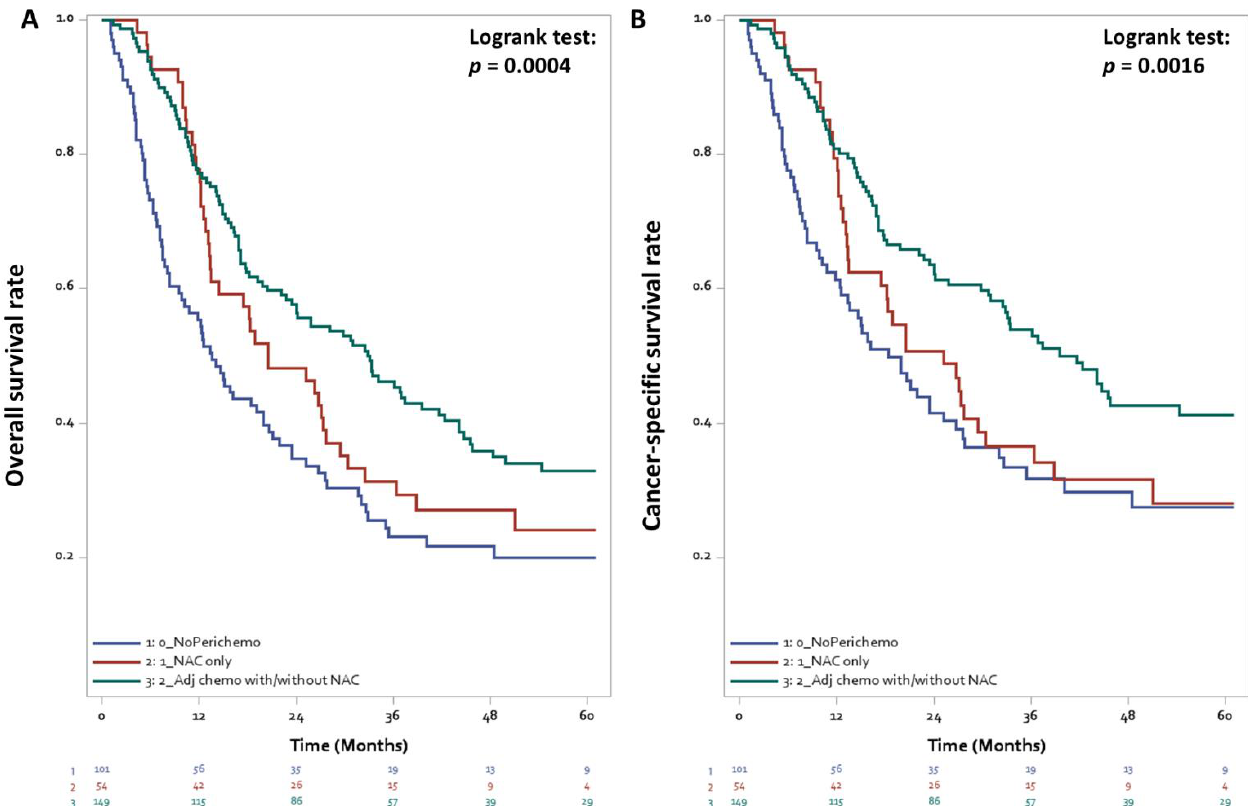
Figure 3. Overall survival ( A ) and cancer-specific survival ( B ) curves stratified by peri-operative chemotherapy in bladder cancer patients with lymph node metastases treated with radical cystectomy.